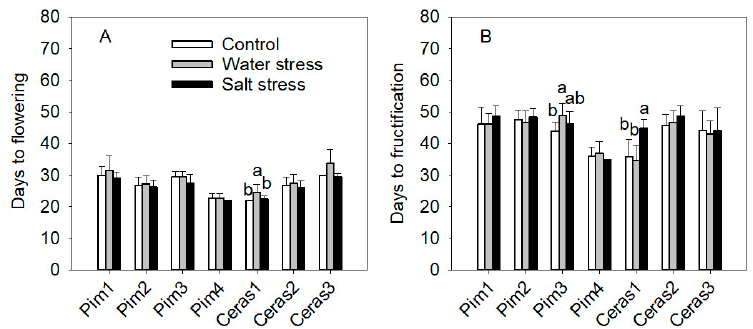
Figure 7. Days to flowering ( A ) and days to fructification ( B ) in accessions Pim1, Pim2, Pim3, Pim4, Ceras1, Ceras2 and Ceras3 under control, water stress and salt treatments after 75 days treatment. Data are mean values ± SE for n = 8 plants. Within each accession, different letters indicate significant differences at p < 0.05 (LSD test). Analysis of two-way ANOVA is provided in supplementary material in Table S6. SE: Standard error.